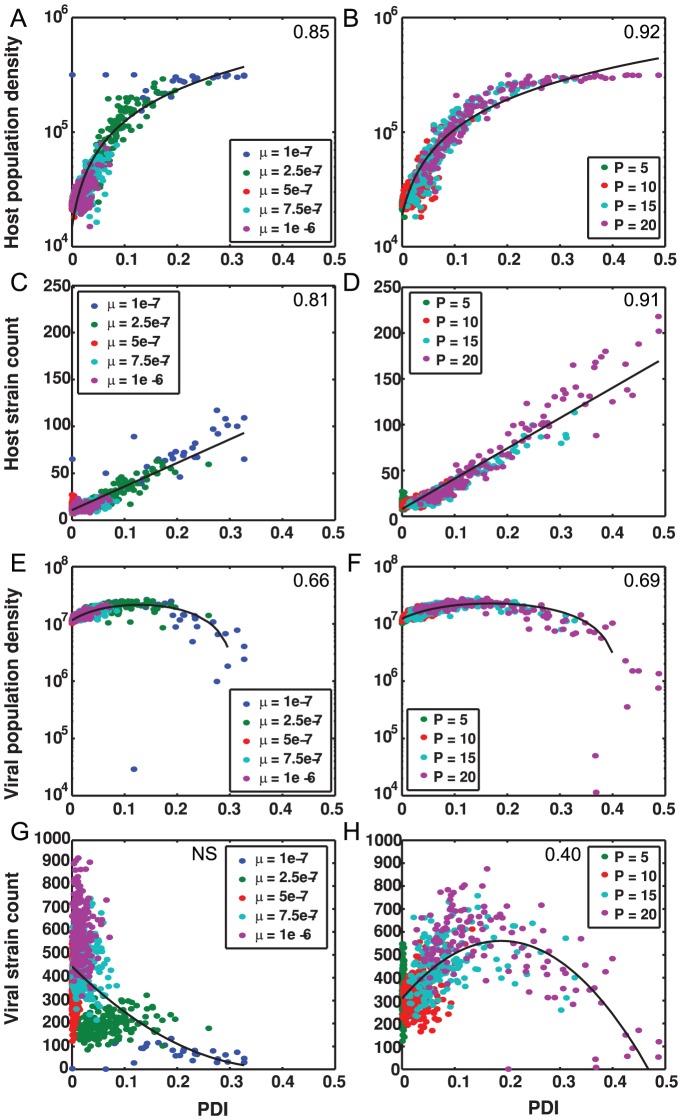
PDI and population measures when varying mutation rate and protospacer number.High PDI is associated with (A–B) increases in host population density, (C–D) increases in host strain count, non-monotonic changes (E–F) in viral population density, and non-monotonic changes (G–H) in viral strain count. Left column is varying mutation rate, μ, and right column is varying protospacer number, P. Unless varied, parameters are S = 10, P = 10, q = 10−5, μ = 5×10−7. Each point is the median from the last 500 hours of a single simulation. Note that both viral population density and viral strain count are unimodally related to PDI, with the lowest levels of both viral population density and strain count occurring at high PDI. The Spearman rank correlation coefficients of all comparisons, noted in the upper right corner of Figure panels, are significant at p<0.001. These relationships, including those that are non-monotonic, are discussed further in the main text.